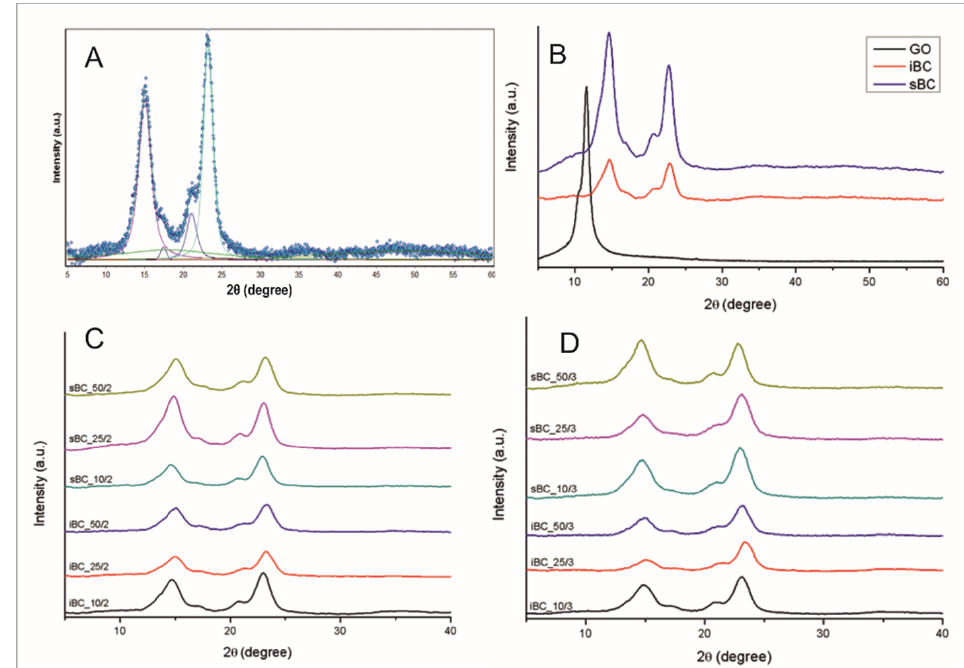
Figure 11. Distribution of XRD pattern for sBC sample into crystalline and amorphous components ( A ), XRD patterns of GO and neat BC produced by K. intermedius and K. sucrofermentans ( B ), and XRD patterns of GO/BC nanocomposites with different levels of GO addition with two loadings ( C ) and three loadings ( D ).